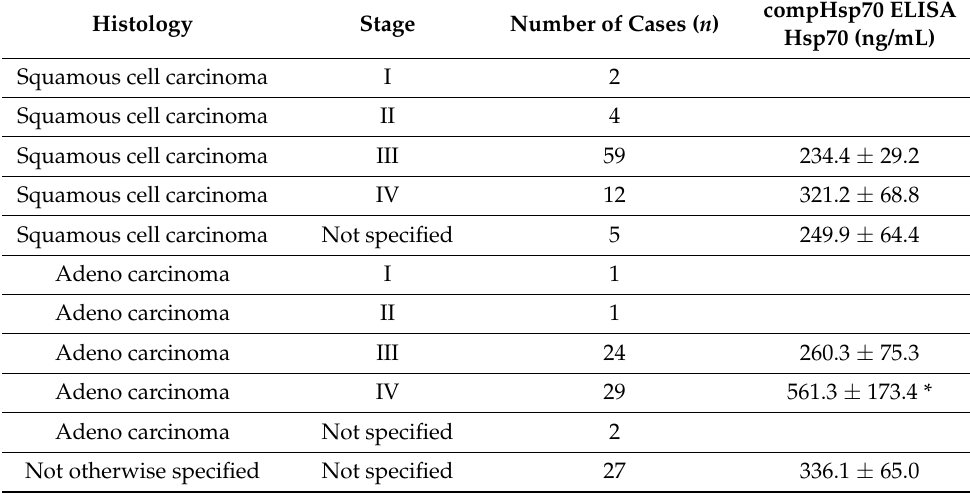
Table 4. Histology, tumor stage and mean Hsp70 values of squamous cell and adeno non-small cell lung cancer (NSCLC) patients. Data uncertainty is given as Standard Error of the Mean (SEM). An asterisk marks statistically significant differences between NSCLC stage III and IV, as determined by the one-way analysis of variance (ANOVA) with the Tukey test for multiple comparisons in RStudio; * p <